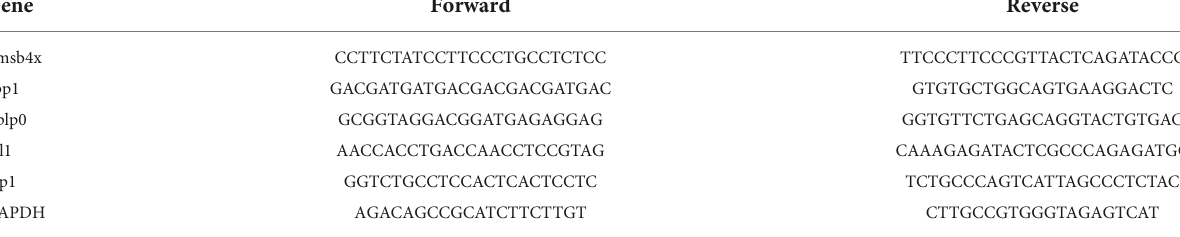
TABLE 1 Forward and reverse primer sequences for quantitative real-time polymerase chain reaction (qPCR). Gene